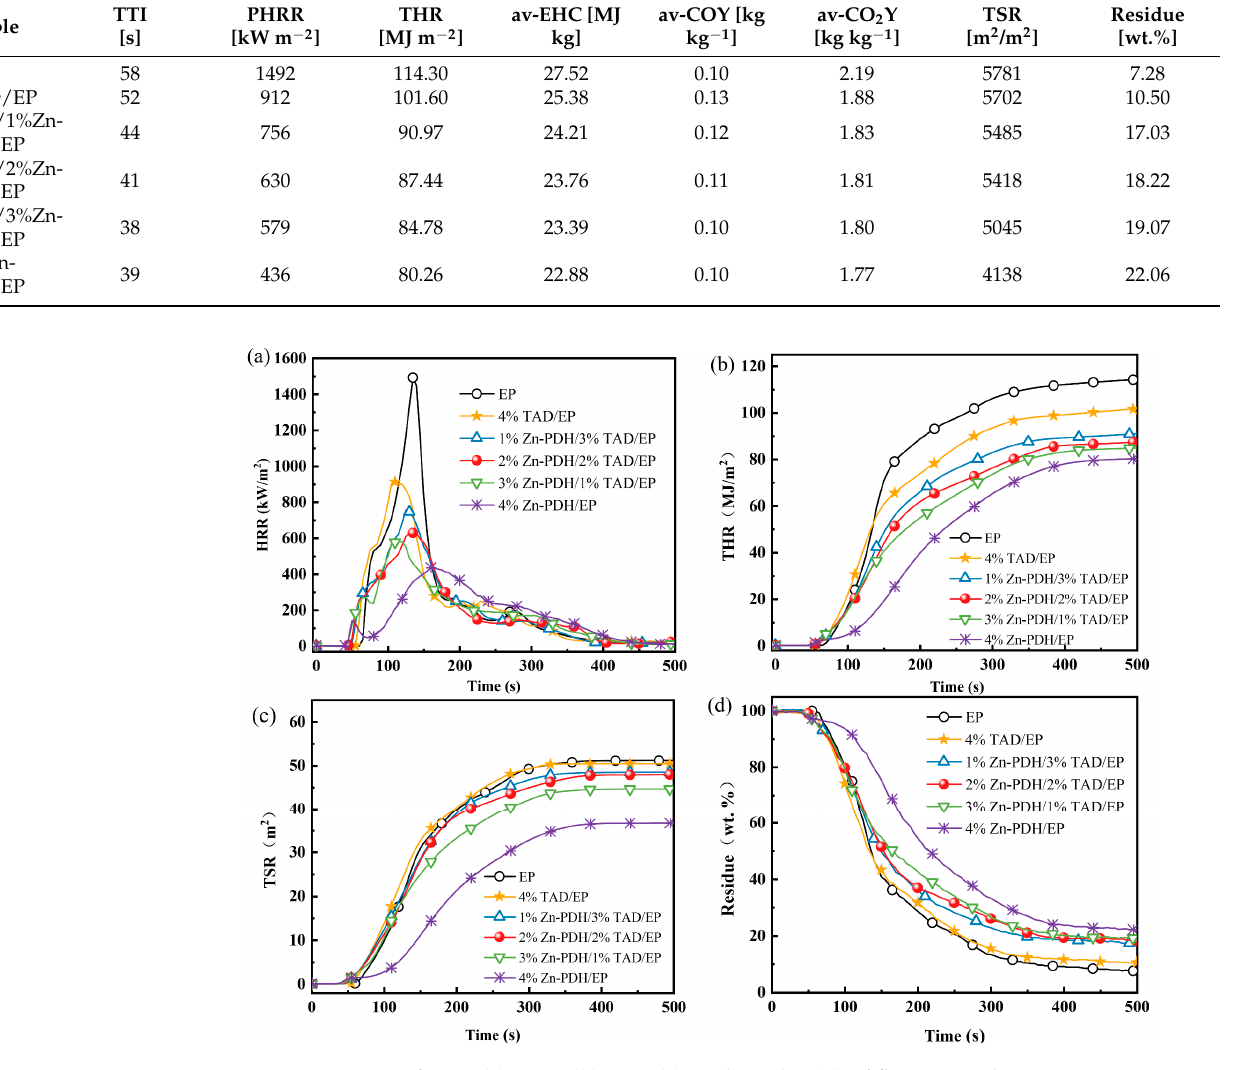
Figure 3. Curve of HRR ( a ), THR ( b ), TSR ( c ), and residue ( d ) of flame-retardant EP. Table 5. Quantitative assessment of three main flame-retardant modes of